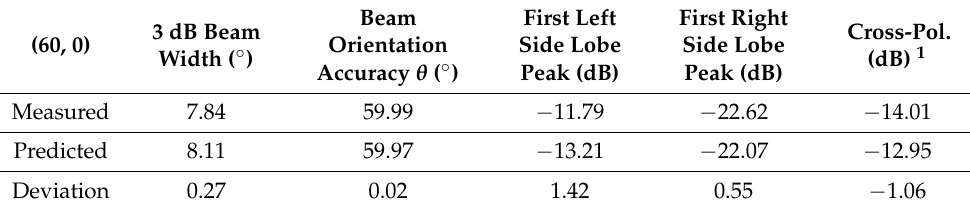
Table 3. Detailed factor comparison of predicted and measured beam profile at ( θ , ϕ ) = (60, 0). 1 The cross-polarization is the maximum difference between the main polarization and the cross- polarization within a 3 dB beamwidth. (60,